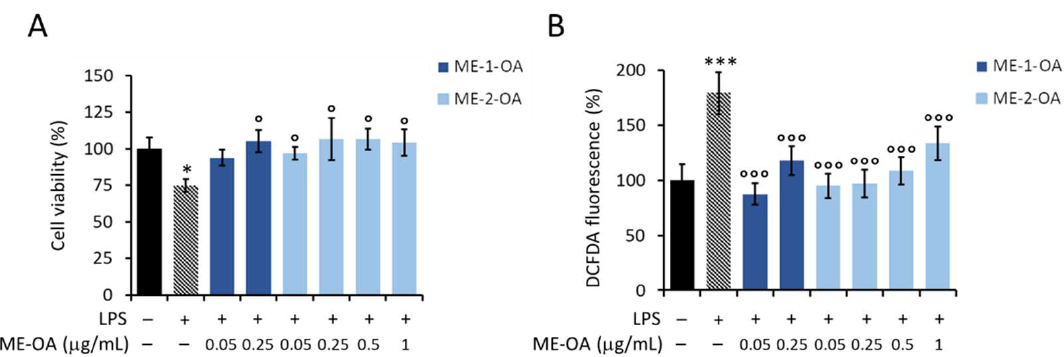
Figure 8. Effect of OA loaded into ME-1 and ME-2, i.e., ME-1-OA and ME-2-OA, respectively, on LPS-damaging effects in RAW 264.7 cells. ( A ) MTT assay and ( B ) detection of intracellular ROS production in cells starved for 6 h and then treated for 18 h with ME-1-OA at 0.05 and 0.25 μg/mL OA loaded (blue bars), and with ME-2-OA at 0.05–1 μg/mL OA loaded (light-blue bars), in the presence of LPS (+). Values are expressed as percentages compared to untreated (−) and LPS-unstimulated (−) control cells. Data are reported as mean ± SD of three independent experiments. Tukey’s test ( n = 3). * p < 0.05; *** p < 0.001; vs. untreated and LPS-unstimulated control cells. ◦ p < 0.05; ◦◦◦ p < 0.001 vs. untreated but LPS-stimulated control